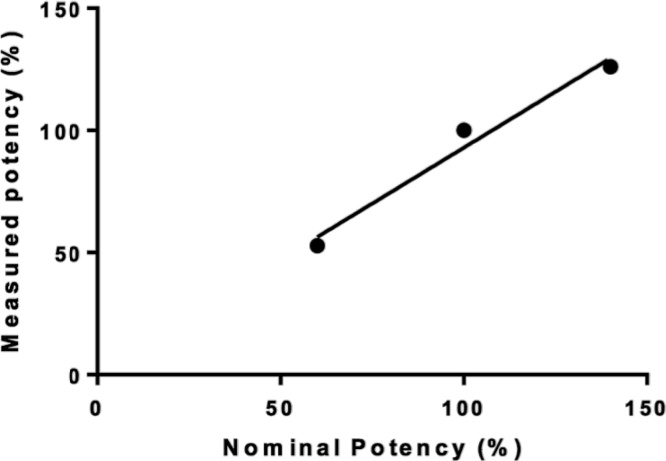
Accuracy of Annexin positive cells in response to rituximab. Accuracy was determined by dilutional linearity evaluated in a dilutional range of sample recoveries at 60, 100 and 140 %. Relationship between nominal and measured potency (EC50, r2 = 0.97, slope: 0.92).